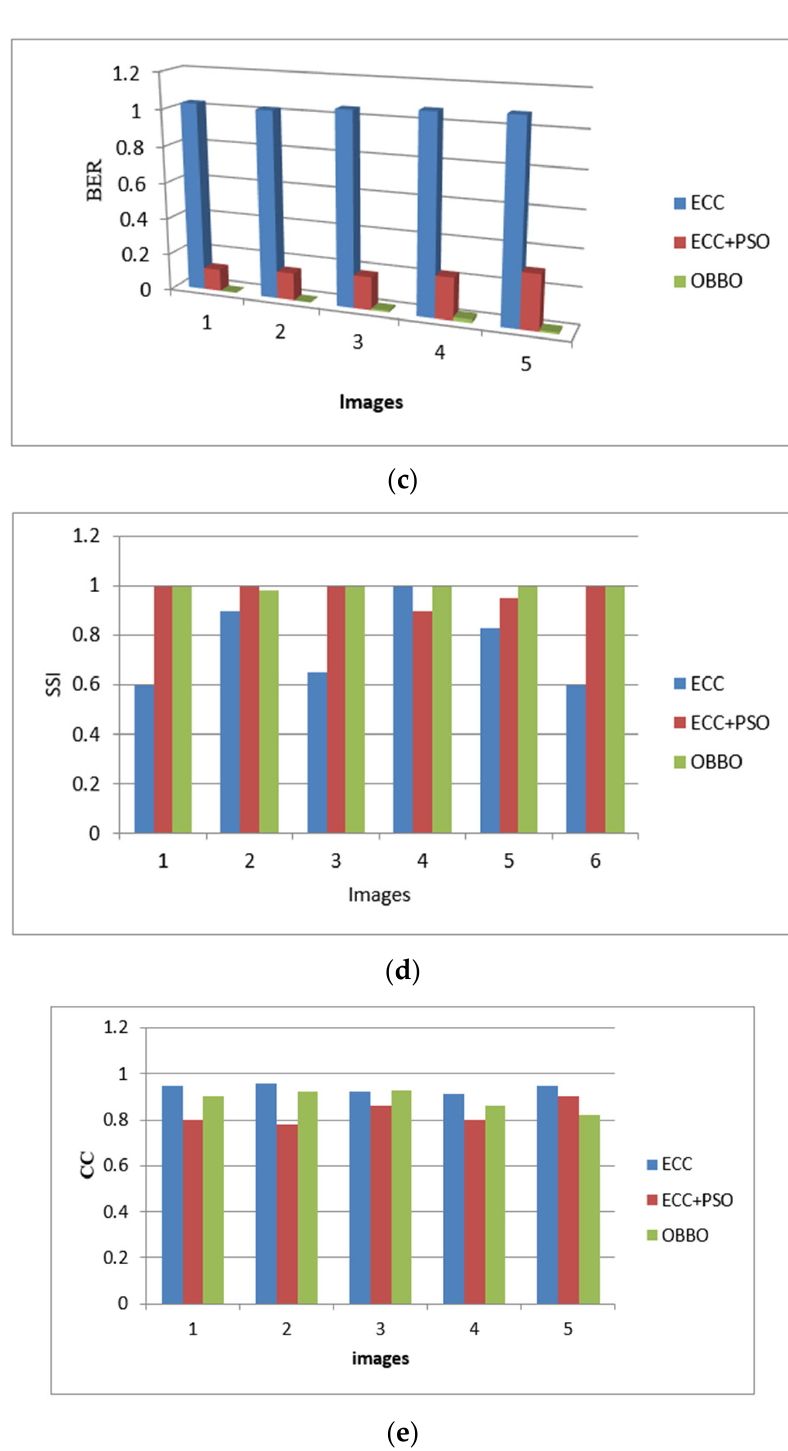
Figure 5. Comparison of the suggested methods. ( a ) Comparative analysis for PSNR ( b ) Comparative analysis for MSE ( c ) Comparative analysis for BER ( d ) Comparative analysis for SSI ( e ) Comparative analysis for CC.